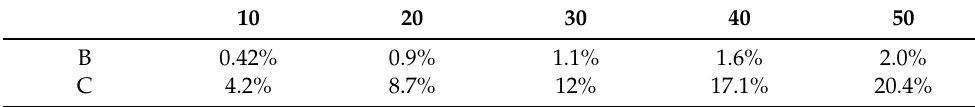
Table 1. Percentage increase in earth loss resistance under B and C conditions.